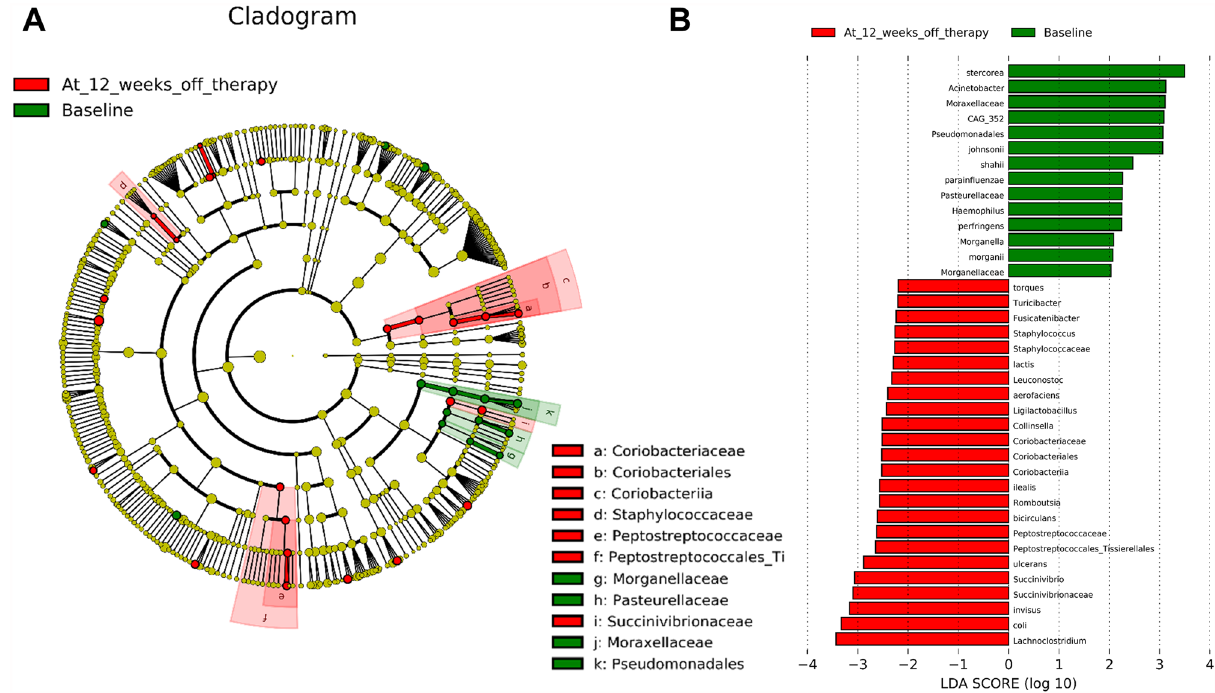
Figure 4. Linear discriminant analysis effect size (LEfSe) and linear discriminant analysis (LDA) to differentiate between gut microbiome measured before and 12 weeks after eradication of hepatitis C virus (HCV). In the left panel ( A ), cladogram showing the most discriminative bacteria identified by LEfSe. Red or green regions/ branches indicate increase or decrease in the relative abundance of bacterial population following HCV clearance. In the right panel ( B ), LDA scores indicate significant differences in the microbial compositions before and after eradication of HCV